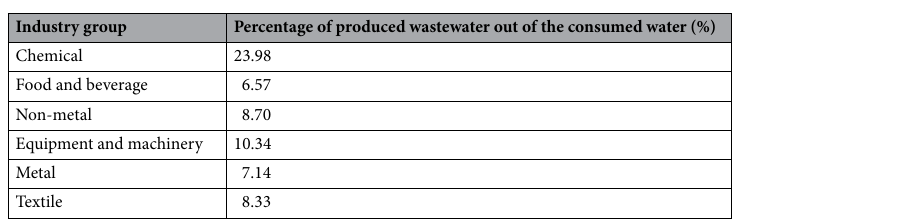
Table 1. Percentages of industrial